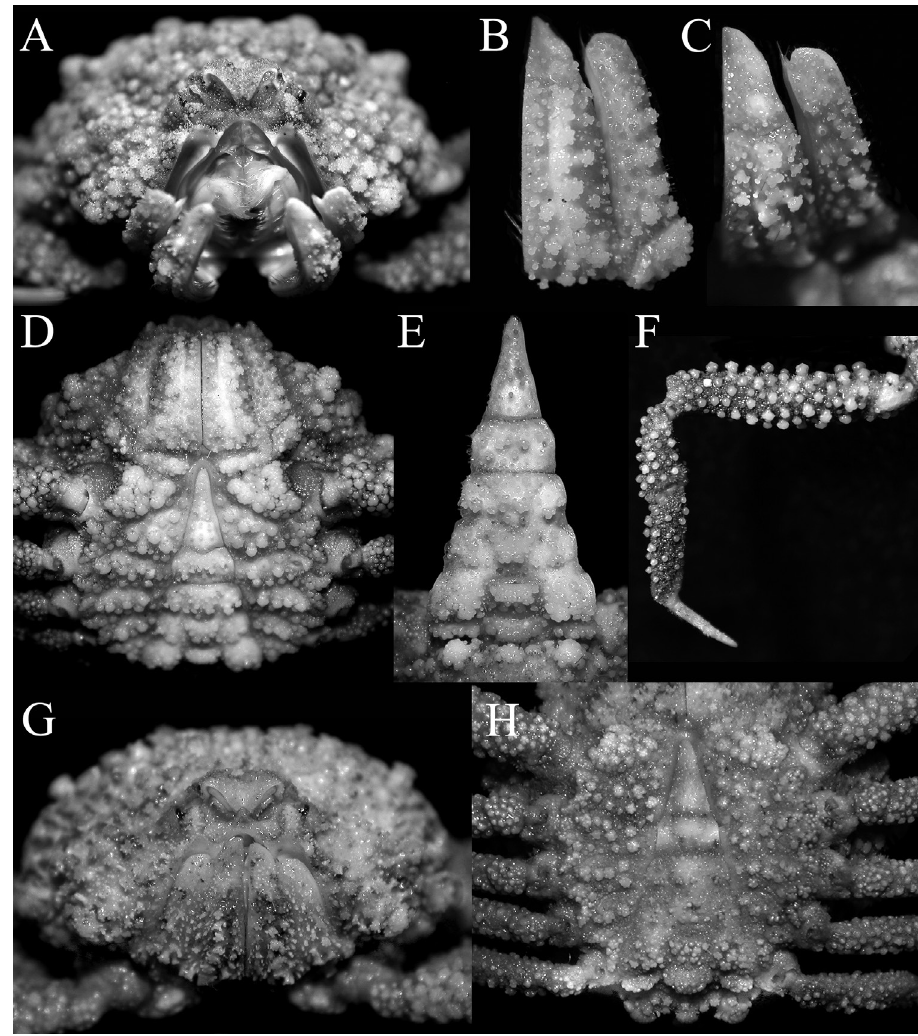
Figure 8. Pariphiculus stellatus sp. n. A–F holotype male (27.7 × 24.5 mm) (ASIZ 75485), Taiwan G, H male (24.3 × 21.6 mm) (ZRC 2007.590), Philippines. A, G frontal view of cephalothorax showing orbit, antennae, antennules and buccal cavity B, C outer view of left third maxilliped D, H male thoracic sternum and pleon E male pleon F left third ambulatory